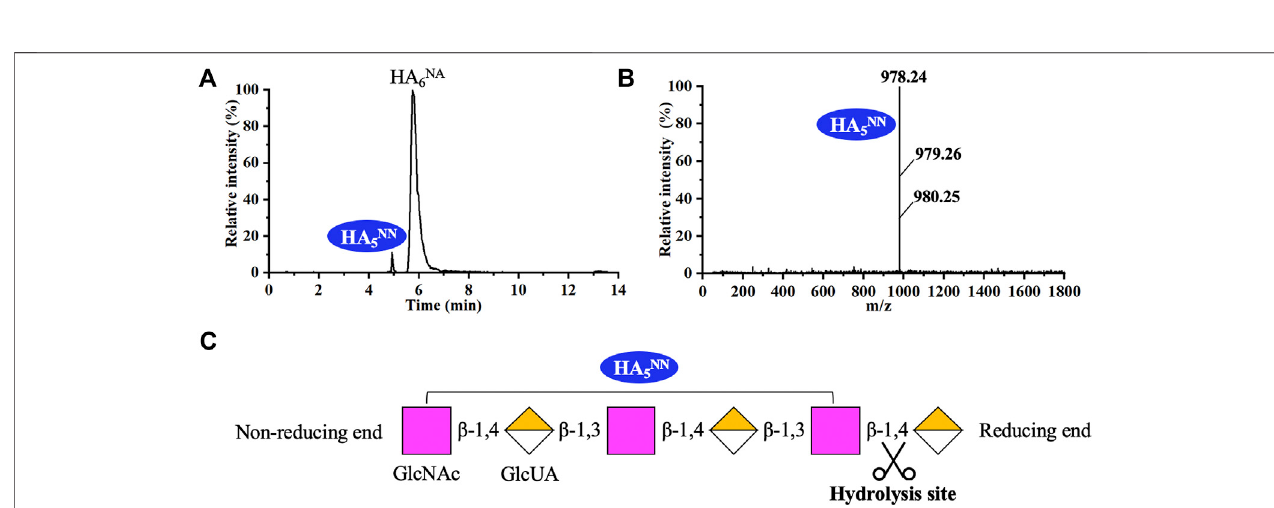
FIGURE5| Analysisoftheend productsofHA 6NA hydrolyzedbyrecombinant hPH20. (A,B) Extracted ionchromatogram/massspectraofendproductsofHA 6NA by HPLC-MS. (C) Schematic diagram of the hydrolysis process of HA 6 NA .